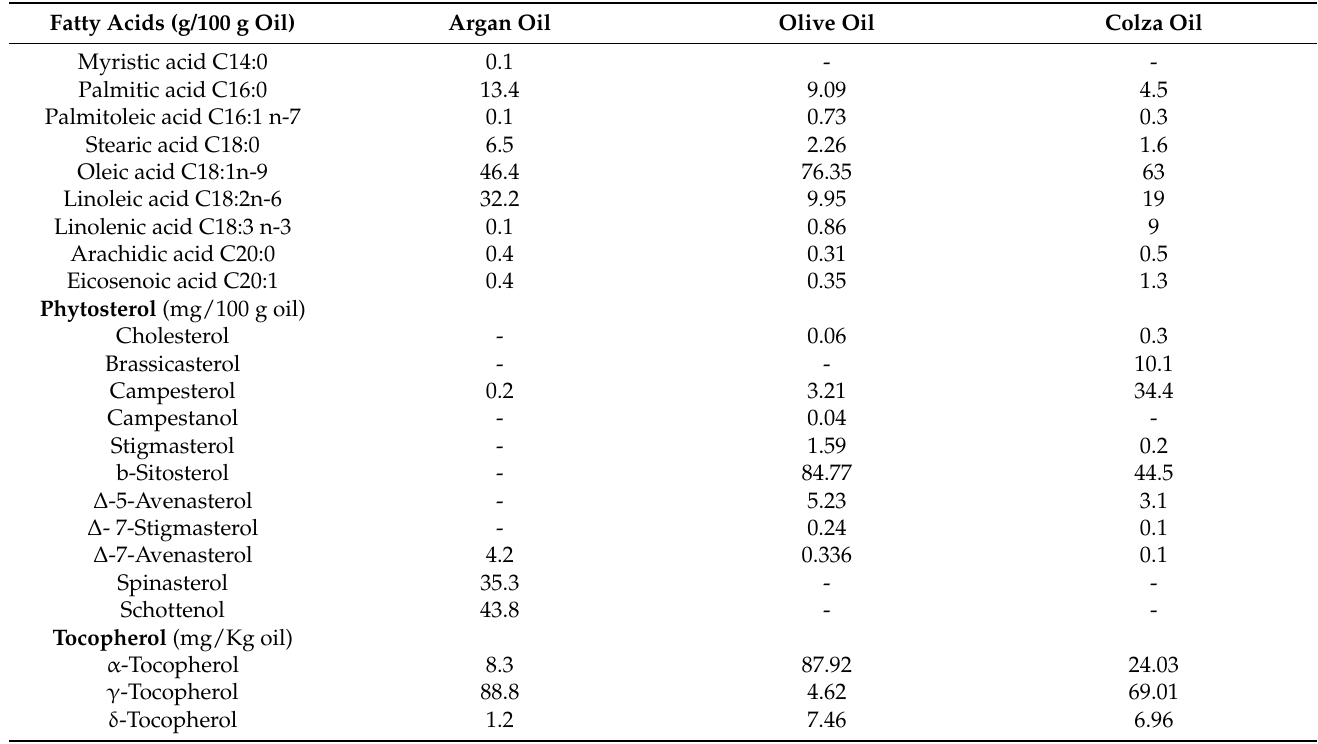
Table 1. Composition of